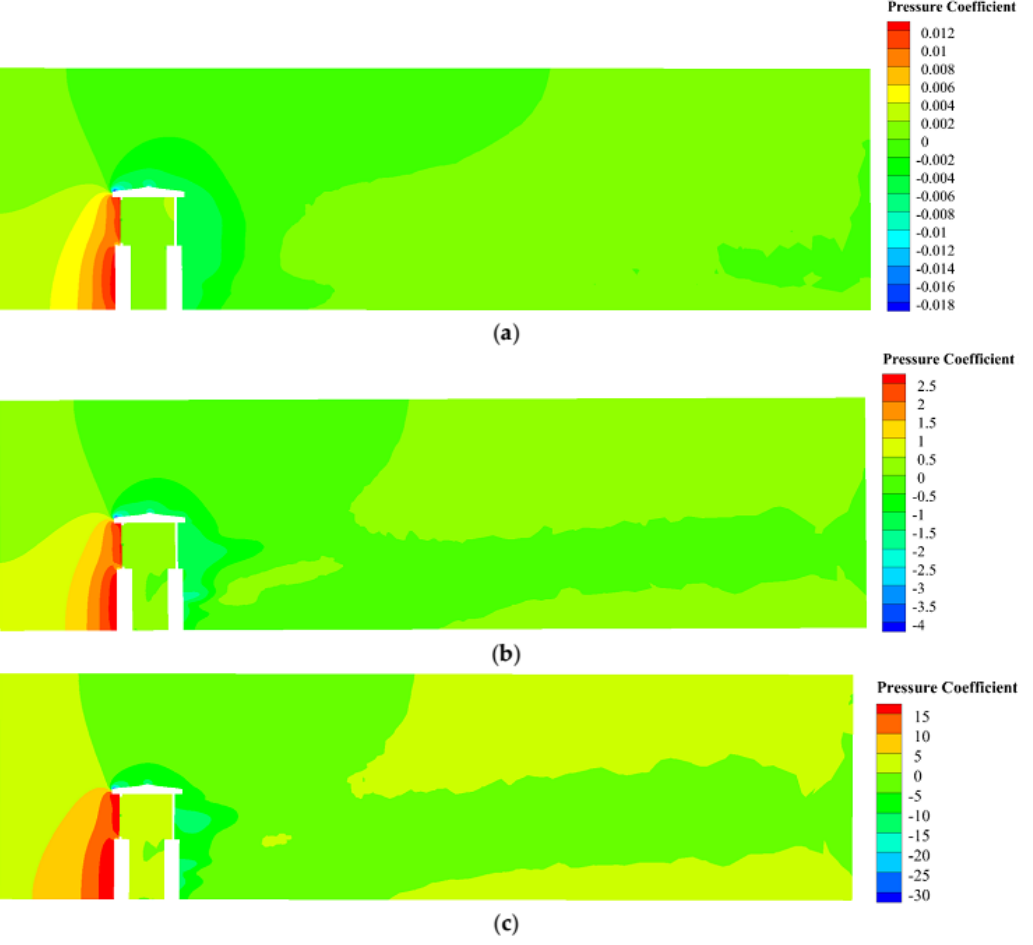
Figure 17. Distribution of pressure coefficient in xz-plane for different inlet wind velocities: ( a ) 0.1 m/s; ( b ) 1.5 m/s; and ( c ) 4 m/s.